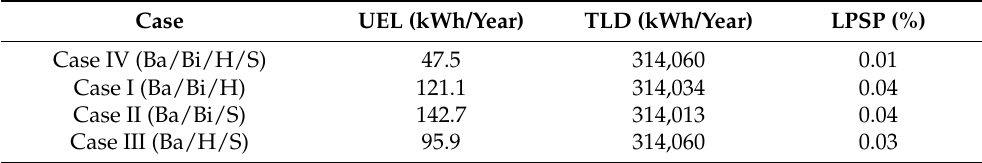
Table 5. Estimation of system reliability for cases I to